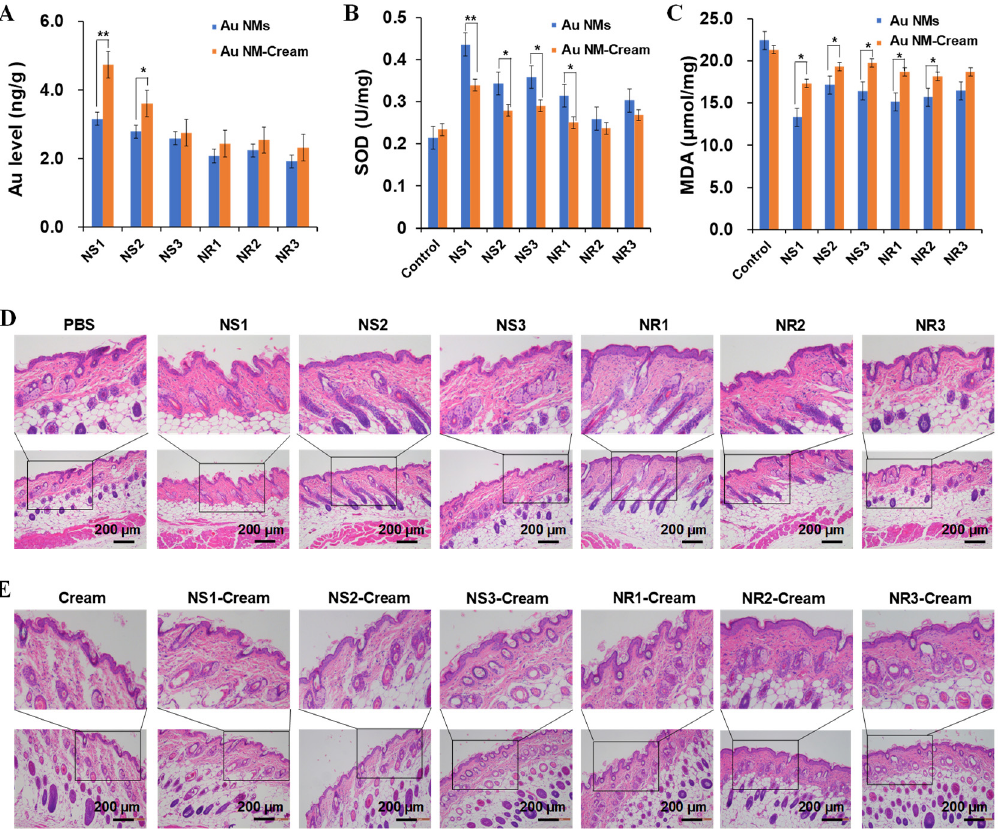
Figure 6. In vivo toxicological assessment of Au NMs and Au NM − Cream in hairless mice. ( A ) Au accumulation in skin; ( B ) SOD activity; ( C ) MDA content; ( D , E ) H and E staining of skin tissue section of mice exposed to Au NMs ( D ) and Au NM − Cream ( E ). Skin of hairless mice ( n = 3) was daily treated with Au NMs or Au − Cream for 8 h and then gently washed with lukewarm water and dried by medical cotton. Mice were treated once a day for 30 consecutive days. Significant difference * p < 0.05, ** p < 0.01.